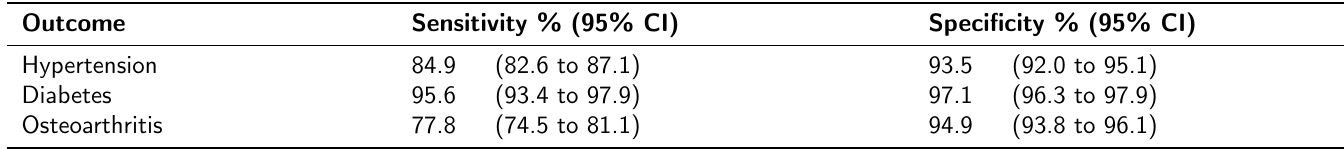
Appendix Table 1: Validation of CPCSSN case-detecting algorithms [16]